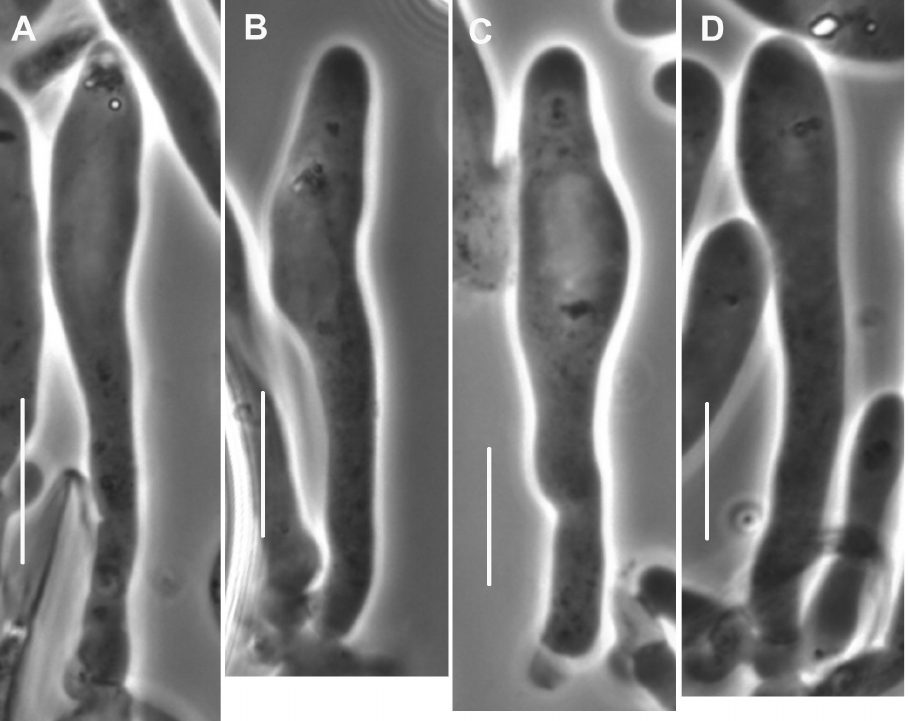
Figure 66. Mycetinis salalis . Pleurocystidia. Standard bars = 10 µm. TFB 5724 (TENN